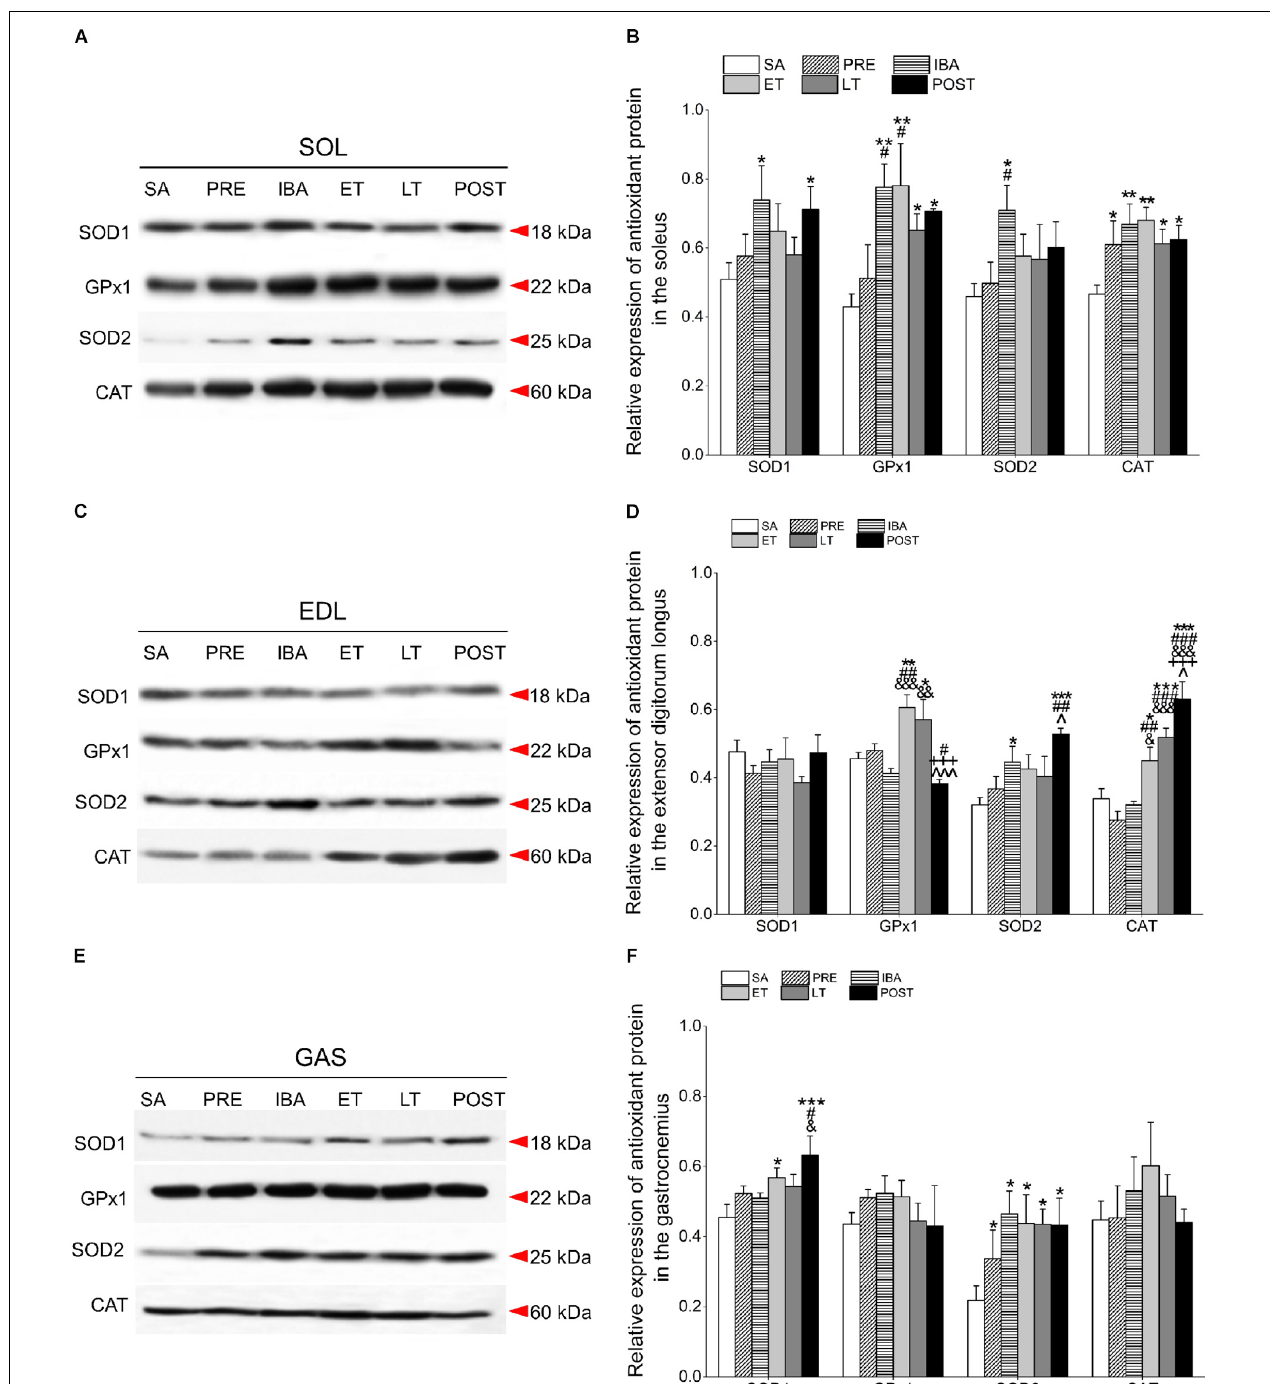
FIGURE 5 | Changes in levels of SOD1, GPx1, SOD2, and CAT proteins in different skeletal muscles of Daurian ground squirrels over the torpor-arousal cycle. (A) Representative immunoblots of SOD1, GPx1, SOD2, and CAT in SOL during six hibernation periods. (B) Relative SOD1, GPx1, SOD2, and CAT protein expression in SOL. (C) Representative immunoblots of SOD1, GPx1, SOD2, and CAT in EDL during six hibernation periods. (D) Relative SOD1, GPx1, SOD2, and CAT protein expression in EDL. (E) Representative immunoblots of SOD1, GPx1, SOD2, and CAT in GAS during six hibernation periods. (F) Relative SOD1, GPx1, SOD2, and CAT protein expression in GAS. SA, summer active; PRE, pre-hibernation; IBA, interbout arousal; ET, early torpor; LT, late torpor; POST, post-hibernation. Values are means ± SEM, n = 8. ∗ P < 0.05, Compared with SA; ∗∗ P < 0.01, compared with SA; ∗∗∗ P < 0.001, compared with SA; # P < 0.05, compared with PRE; ## P < 0.01, compared with PRE; ### P < 0.001, compared with PRE; & P < 0.05, compared with IBA; && P < 0.01, compared with IBA; &&& P < 0.001, compared with IBA; +++ P < 0.001, compared with ET; ∧ P < 0.05, compared with LT; ∧∧∧ P < 0.01, compared with LT.